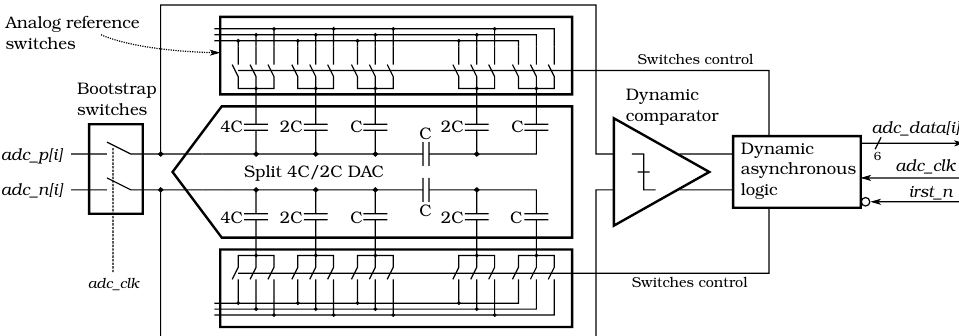
Figure 3. Block diagram of the 6-bit Successive Approximation Register (SAR) Analog-to-Digital Converter